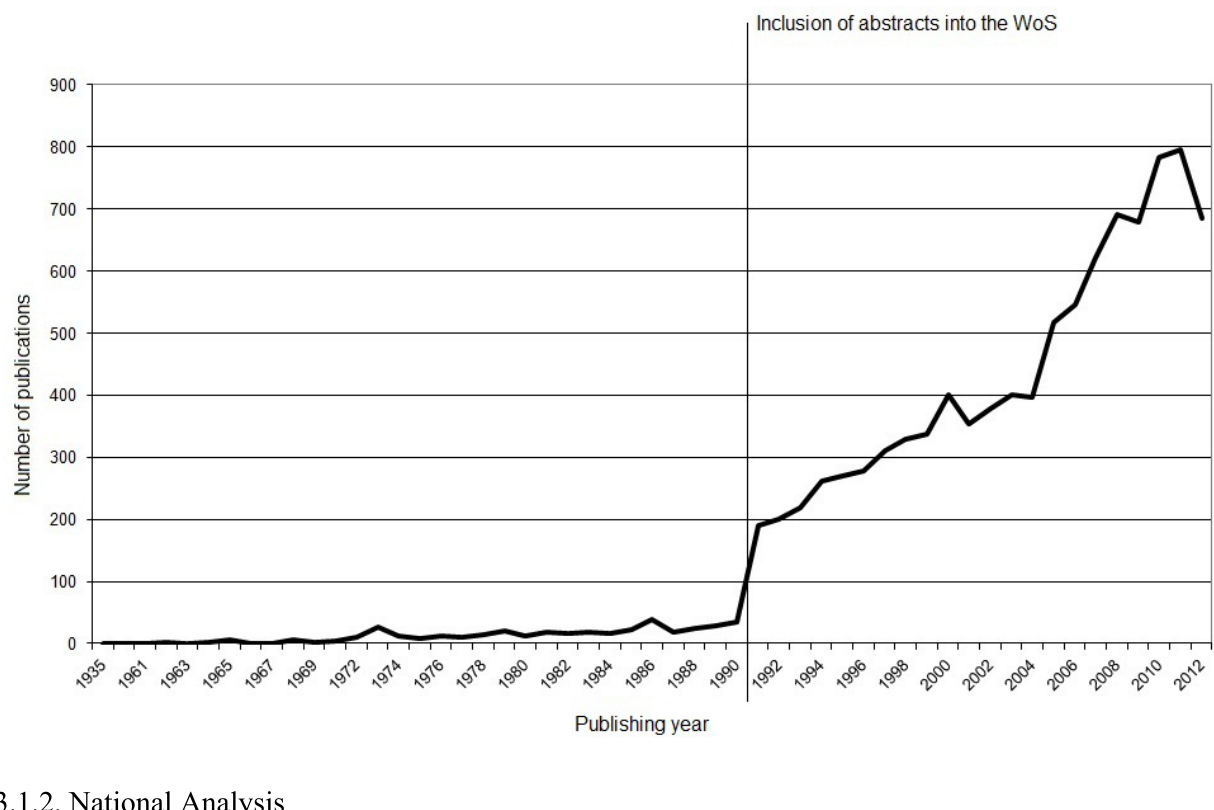
Figure 1. Number of